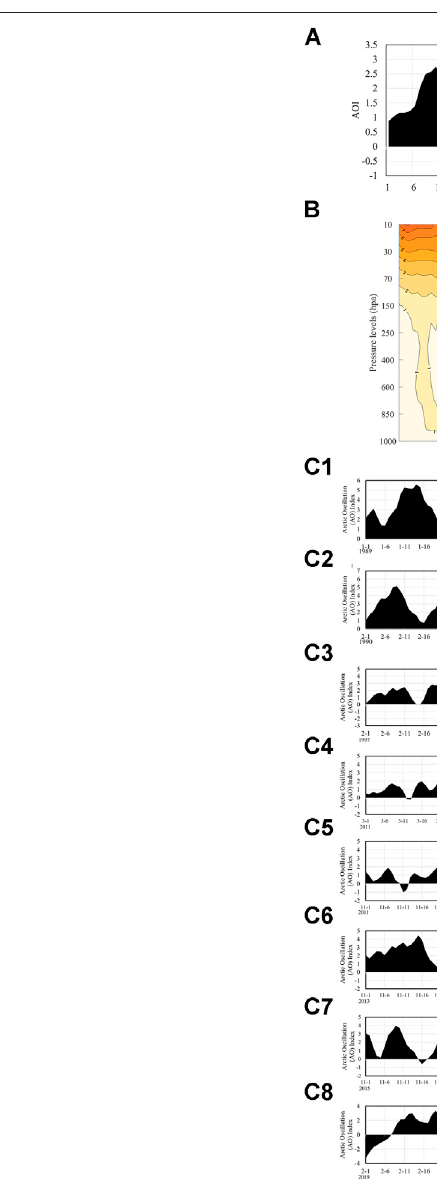
FIGURE 7 | (A) Composite AOI within the following 90 days after the start of eight historical positive AOI events. (B) Composite vertical ZCA pro fi le within the following90daysafter thestartofthese eightpositiveAOIevents.